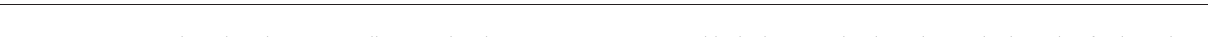
Fig. 2 Ensa KD increases S-phase length. a HeLa cells treated with SC or Ensa siRNA were blocked in G1/S by thymidine and released in fresh medium. Samples were taken at 4, 6, 8 and 10 h after release and processed by FACS to follow S-phase progression. b As for a except that U2OS cells were used and released at 4, 9, 14 and 17 h. c Scheme representing the experiment in which HeLa cells were treated with SC or Ensa siRNA for 48 h, pulsed with 10 µ M EdU for 30 min and, after washing, incubated in fresh medium containing 5 µ M thymidine for 2, 4, 6, 8 and 10 h. After a second pulse of 30 min with 10 µ M, BrdU cells were fi xed for immuno fl uorescence. d EdU/BrdU double staining of siSC and siEnsa-treated cells at 10 h after thymidine release is shown. EdU-positive cells are labelled in magenta and BrdU-positive cells in cyan . Resulting white co-localisation are cells still in S phase. Scale bar , 20 μ m. e The % of EdU/BrdU-positive cells in d was counted and represented as a bar graph of the mean value ± standard deviation. A minimum of 80 cells was counted in each time point. f HeLa cells were or not (CT) transfected with increasing doses of siEnsa (12.5, 25 and 50 nM) and 24 h later synchronised in S phase by thymidine block. Cells were then released and followed by time-lapse microscopy. Time after thymidine release and cell rounding (G2/M transition) for each cell at each siRNA concentration was recorded and represented as a box-and-whiskers diagram showing median and minimum to maximum values. A minimum of 50 cells was counted per condition. g Asynchronous control or HeLa cells stably expressing a siEnsa-resistant transgene of human Ensa (R- Ensa) were transfected with siEnsa1 or with SC siRNA (only for parental cells). Cells were released 24 h later, recovered and used for FACS analysis. h As for g , except that cells were blocked in G1 – S 24 h after transfection by thymidine and 9 h after release used for FACs